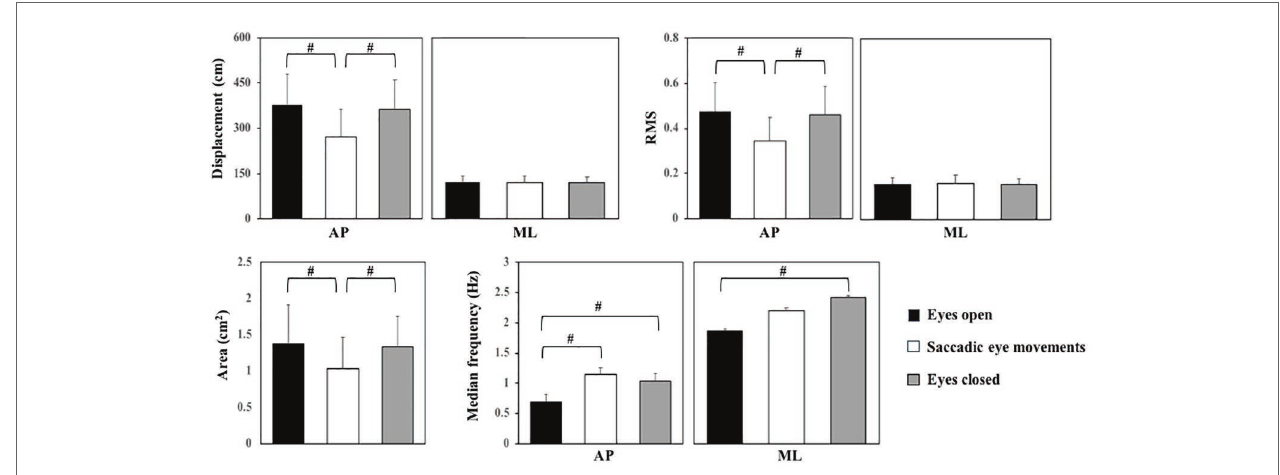
FIGURE 4 | Means and standard deviations (main effect of vision conditions) of the center of pressure parameters for eyes open, saccadic eye movements, and eyes closed condition. AP, anterior-posterior; ML, medial-lateral. #Indicates a significant post hoc difference between conditions.